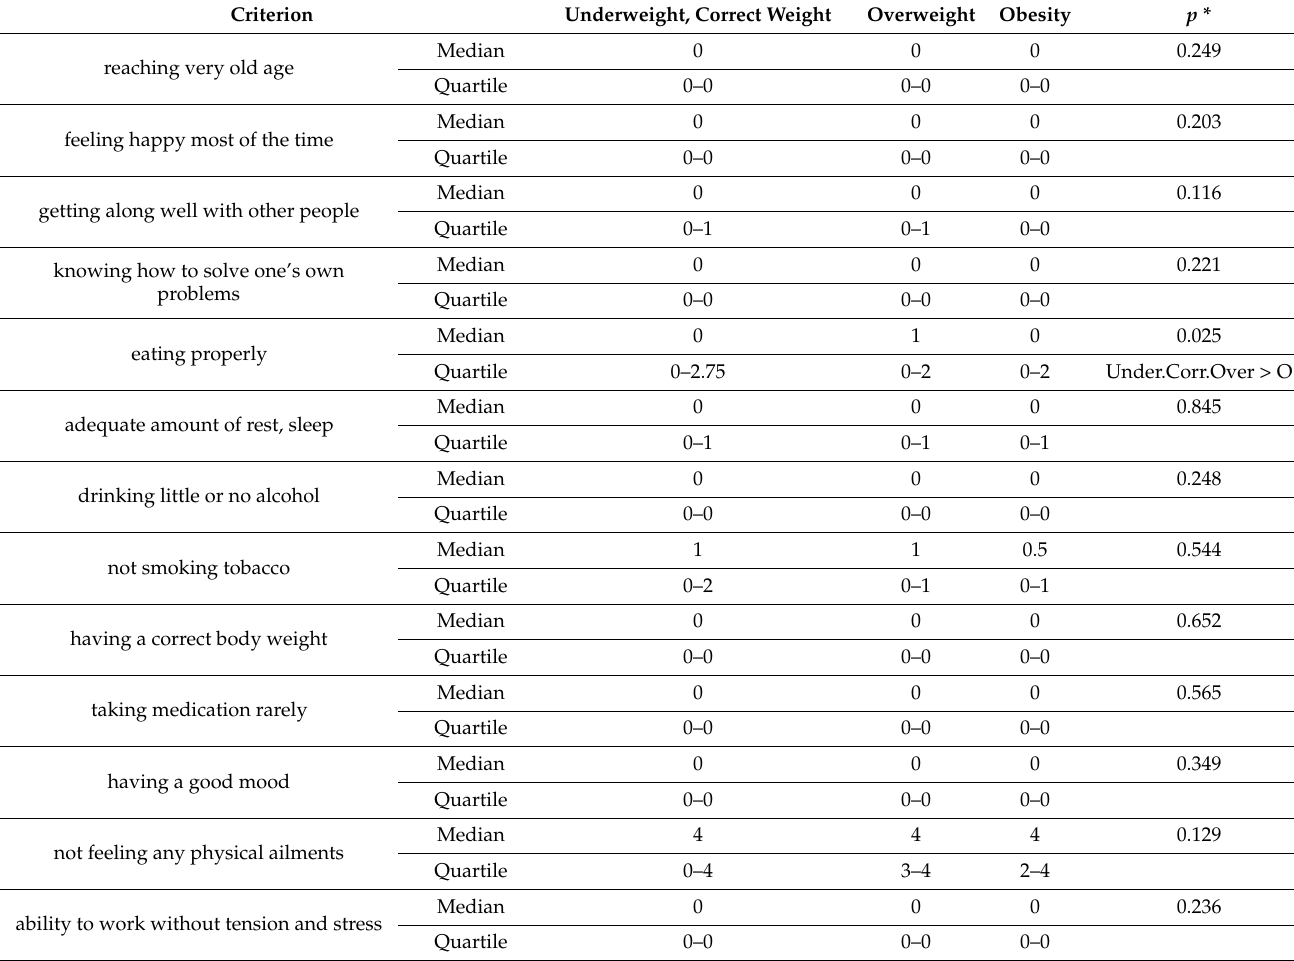
Table 5. Correlations of health statements with the BMI of the